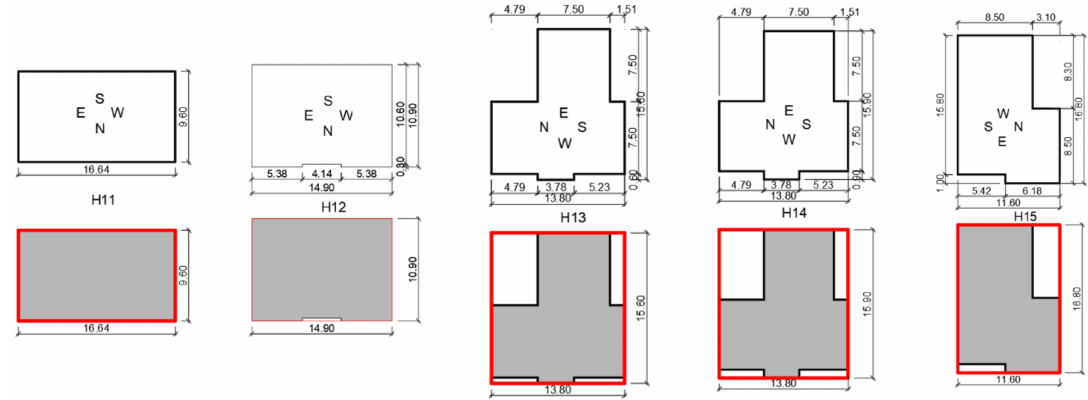
Figure A1. Building plans of the H1–H15 collection with cardinal directions.